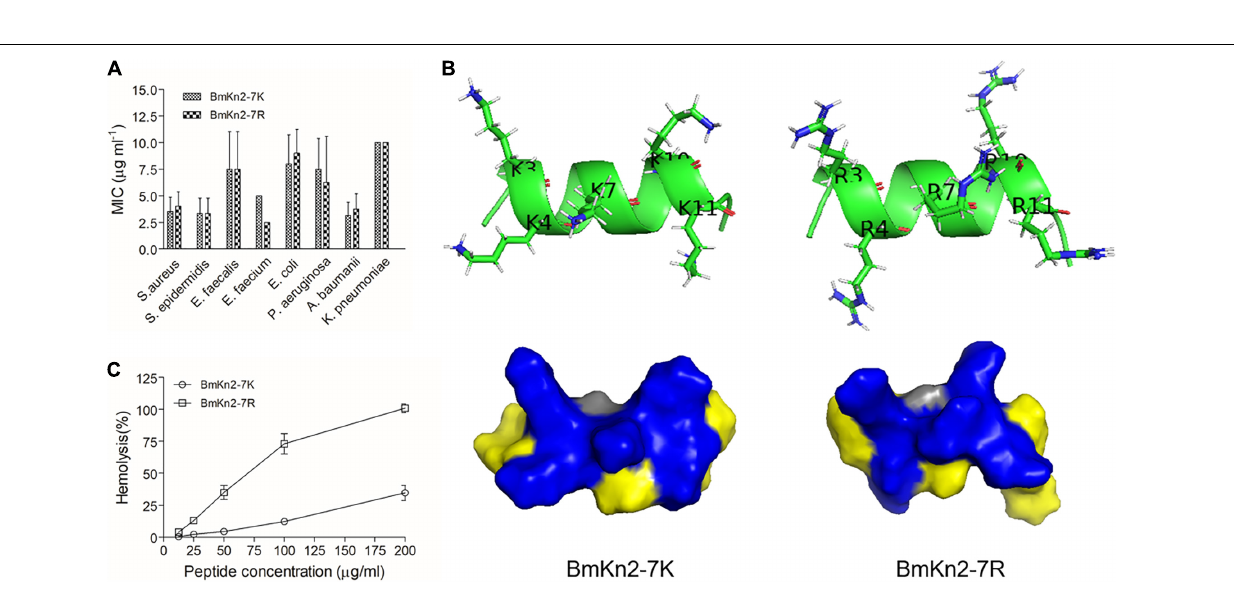
FIGURE 6 | In vivo antimicrobial efficacy of BmKn2-7K. (A) Survival curves of infected mice after treatment with BmKn2-7K. Each cohort of ICR mice ( n = 10) was infected with 5 × 10 7 cfu of S. aureus 4188 (or 6.25 × 10 7 cfu of A. baumannii 906) and cultured for 0.5 h to establish the lethal peritoneal infection model. Drug treatments were performed with a single dose of 20 (or 25) mg kg - 1 body weight BmKn2-7K for the S. aureus 4188 (or A. baumannii 906) infected model, respectively. (B) Quantitative determination of bacterial loads in the peritoneal fluid of S. aureus infected ICR mice ( n = 6). (C) Quantitative determination of bacterial loads in the peritoneal fluid of A. baumannii infected ICR mice ( n = 6). The logarithm value of the number of viable bacteria from each mouse was plotted as individual dots, error bars represent the standard deviation from the mean within each cohort, ** P < 0.01; and *** P < 0.001; ns. represents “no significance”. The statistical significance between the groups was analyzed using one-way ANOVA followed by Tukey’s post hoc test to correct for multiple comparisons.